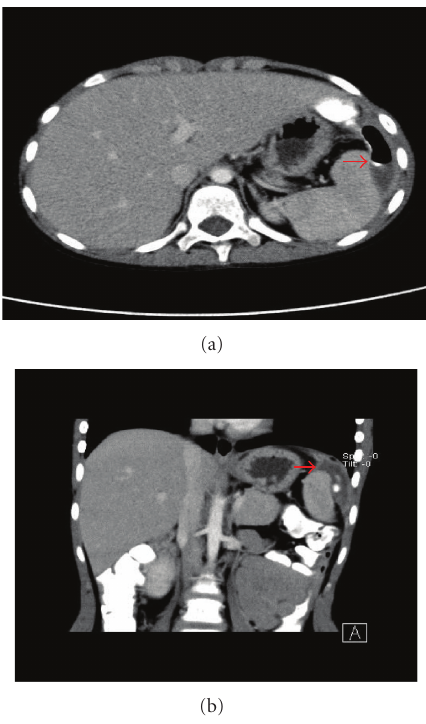
Figure 1: Axial (a) and Coronal (b) abdominal CT projections (with enteric contrast) demonstrate a perisplenic hydroaerial collection with a dense component compatible with enteric content (arrows). A thin fistula ( ∗ ) connects the collection to the colonic lumen. A further retroperitoneal fluid collection is detectable at the left parietal-colonic region.